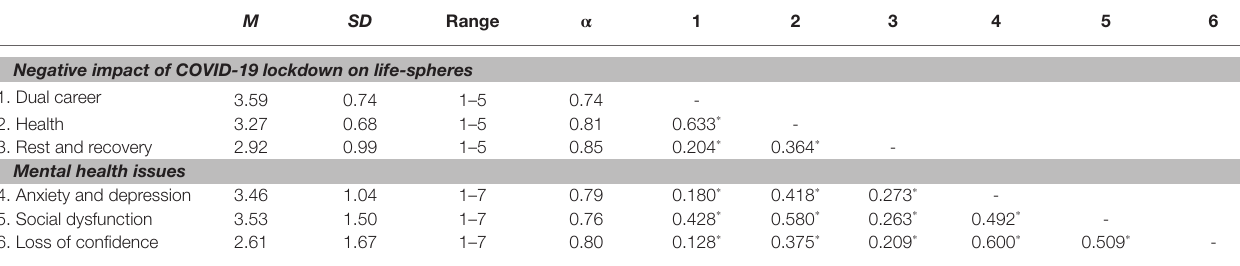
TABLE 1 | Descriptive statistics of negative impact of COVID-19 on life-spheres and mental health issues. M SD Range